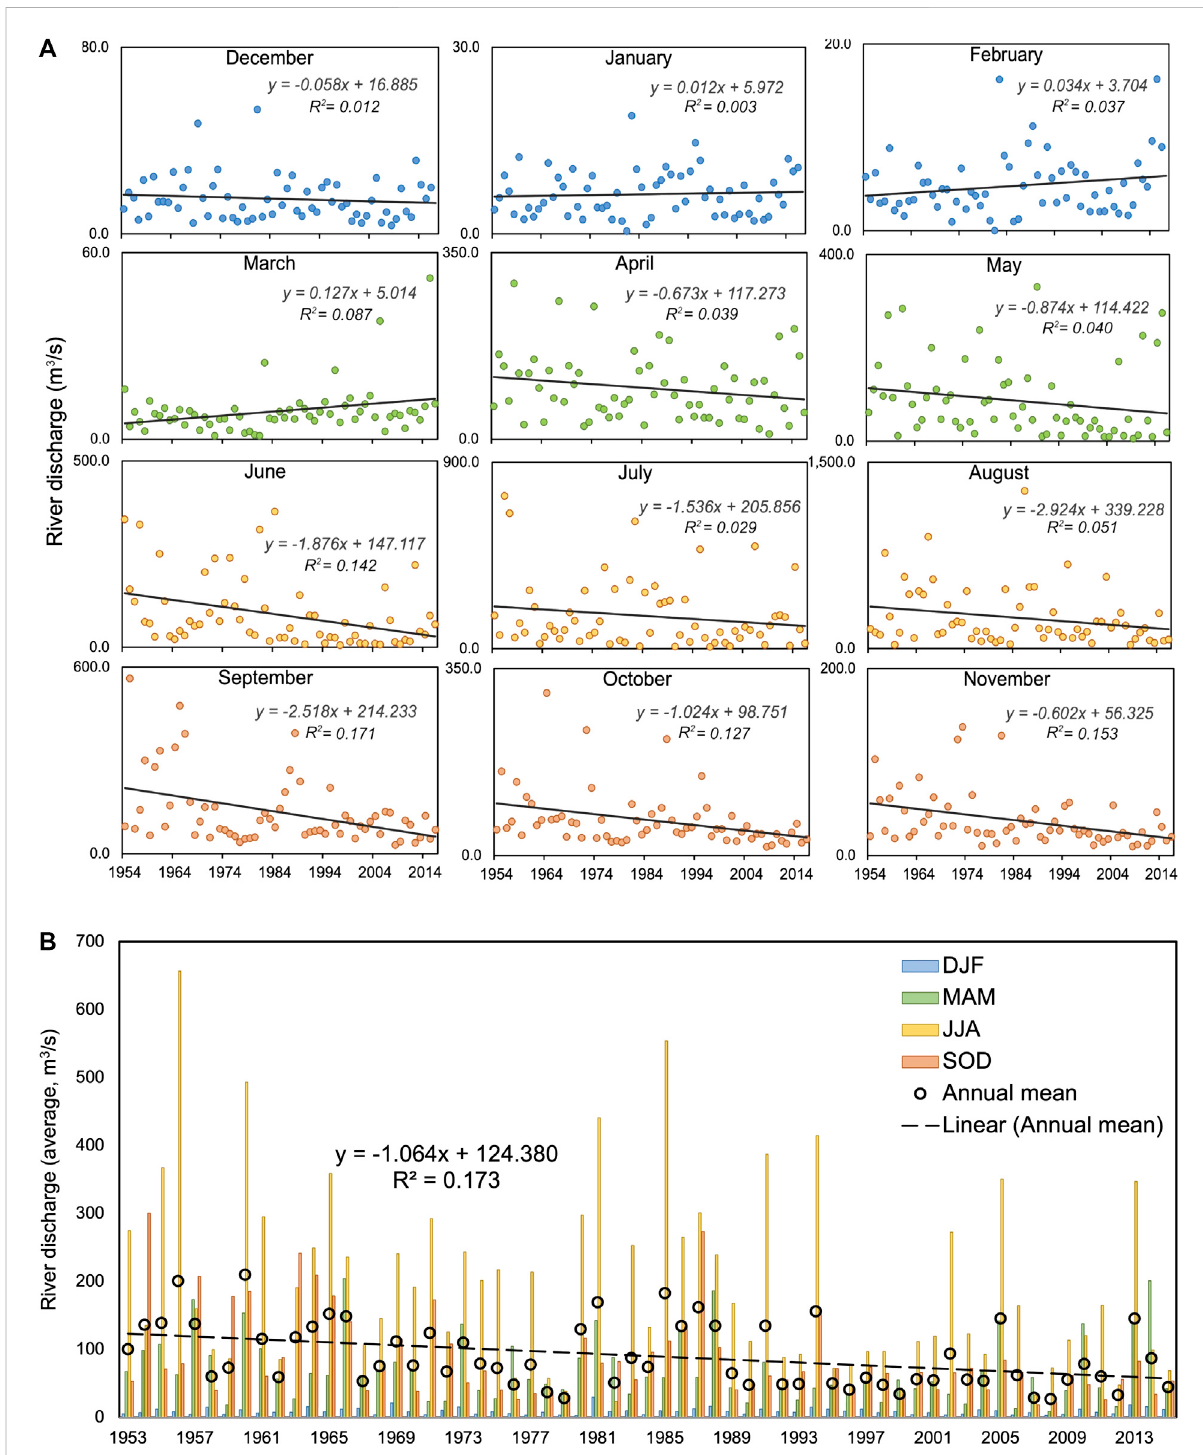
FIGURE 4 Trend and variation of monthly (A) average discharge from January to December (signi fi cance level, p values are less than 0.05 for all months) and (B) seasonal and annual ( p < 0.05) tendency (DJF: December, January, and February; MAM: March, April, and May; JJA: June, July, and August; and SON: September, October, and